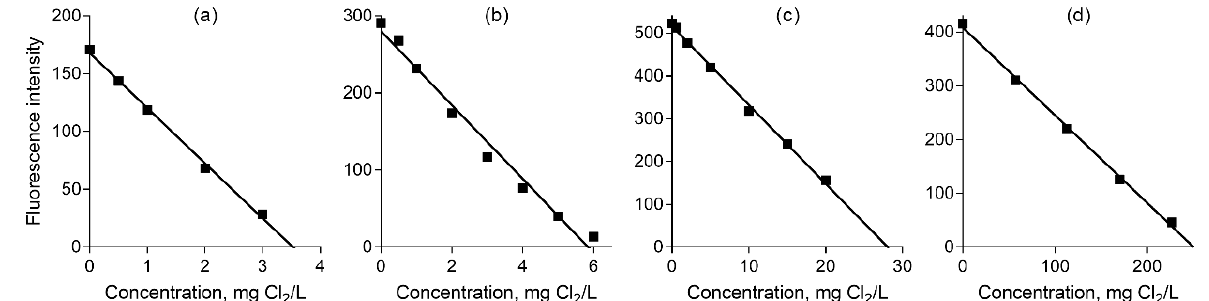
Figure 4. Calibration curves, measured by fluorescence spectrophotometer, with different concentrations and volumes of pyridoxamine and chlorine. ( a ) 1 mL pyridoxamine 25 µ M and 1 mL sample, ( b ) 1 mL pyridoxamine 50 µ M and 1 mL sample, ( c ) 1 mL pyridoxamine 200 µ M and 1 mL sample, and ( d ) 2 mL pyridoxamine 100 µ M and 50 µ L sample. (pH 6, λ ex 330 nm, λ em 396 nm, R 2 > 0.98). Fluorescence intensity on vertical axis shown with arbitrary units.